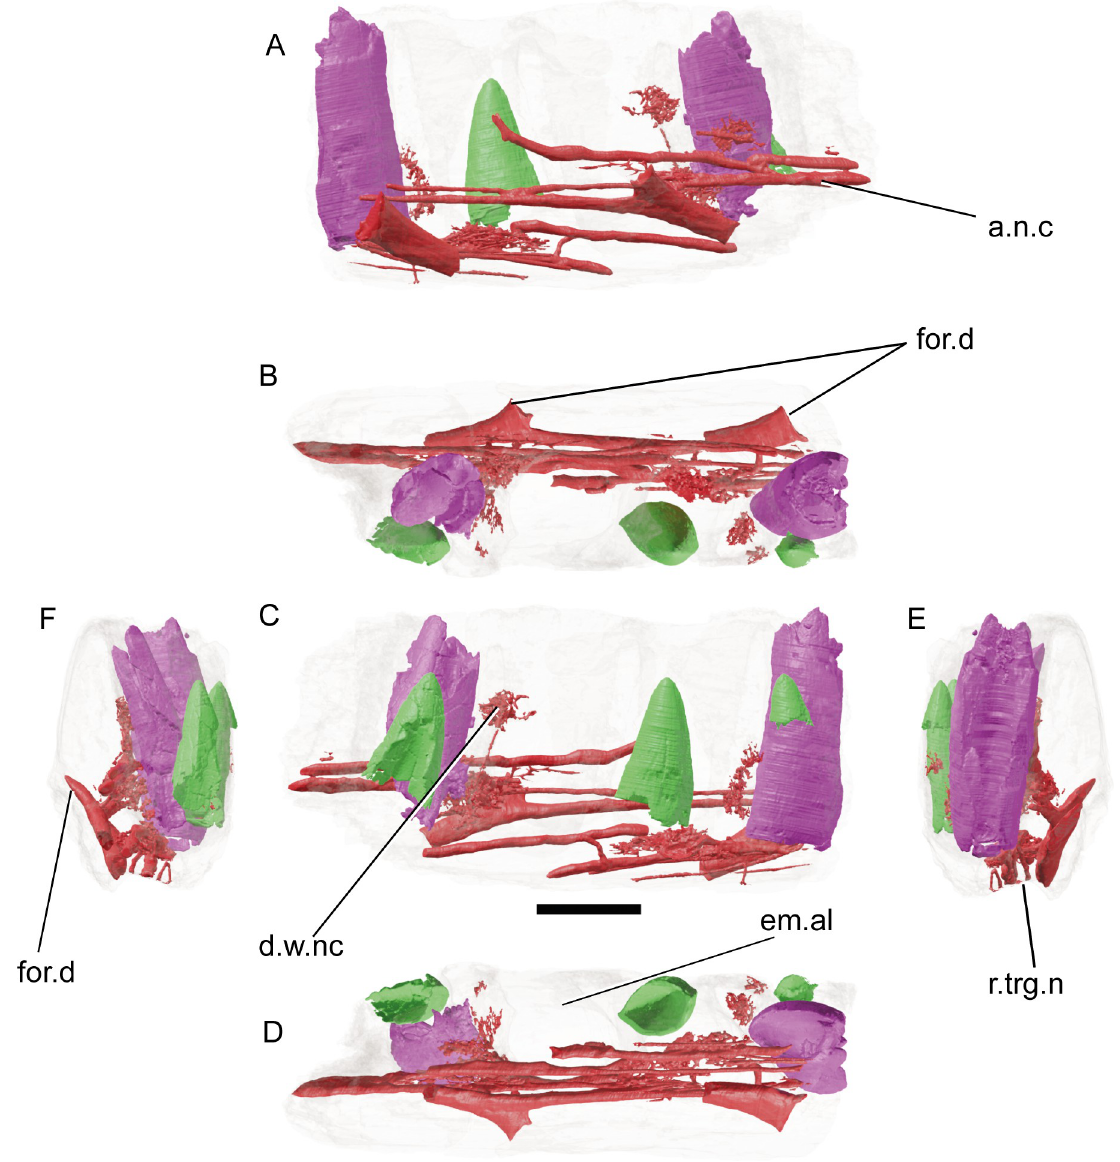
Fig 8. CT-scan of a fragment of dentary of Iberospinus natarioi (ML1190-2), showing the neurovascular system and the replacement teeth. A , lateral, B , occlusal, C , medial, D , ventral, E , anterior, and F posterior views. a.n.c , anteroposterior neurovascular canals, d.w.nc , dense web of neurovascular canals, em.al, empty alveolus, for.d , medial foramina of the dentary, r.trg.n , roof of the mandibular branch of the trigeminal nerve. Scale bar is 10 mm. Voxel size of the model: